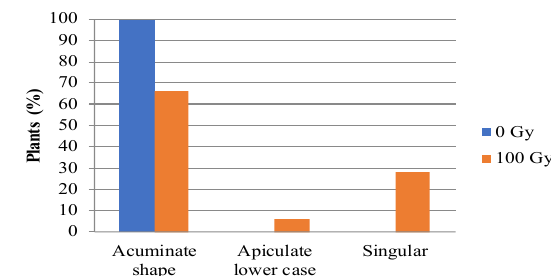
Figure 10. Effect of 100 Gy gamma irradiation on the leaf apex shape of the M1 generation of coffee ( Coffea arabica L. var.